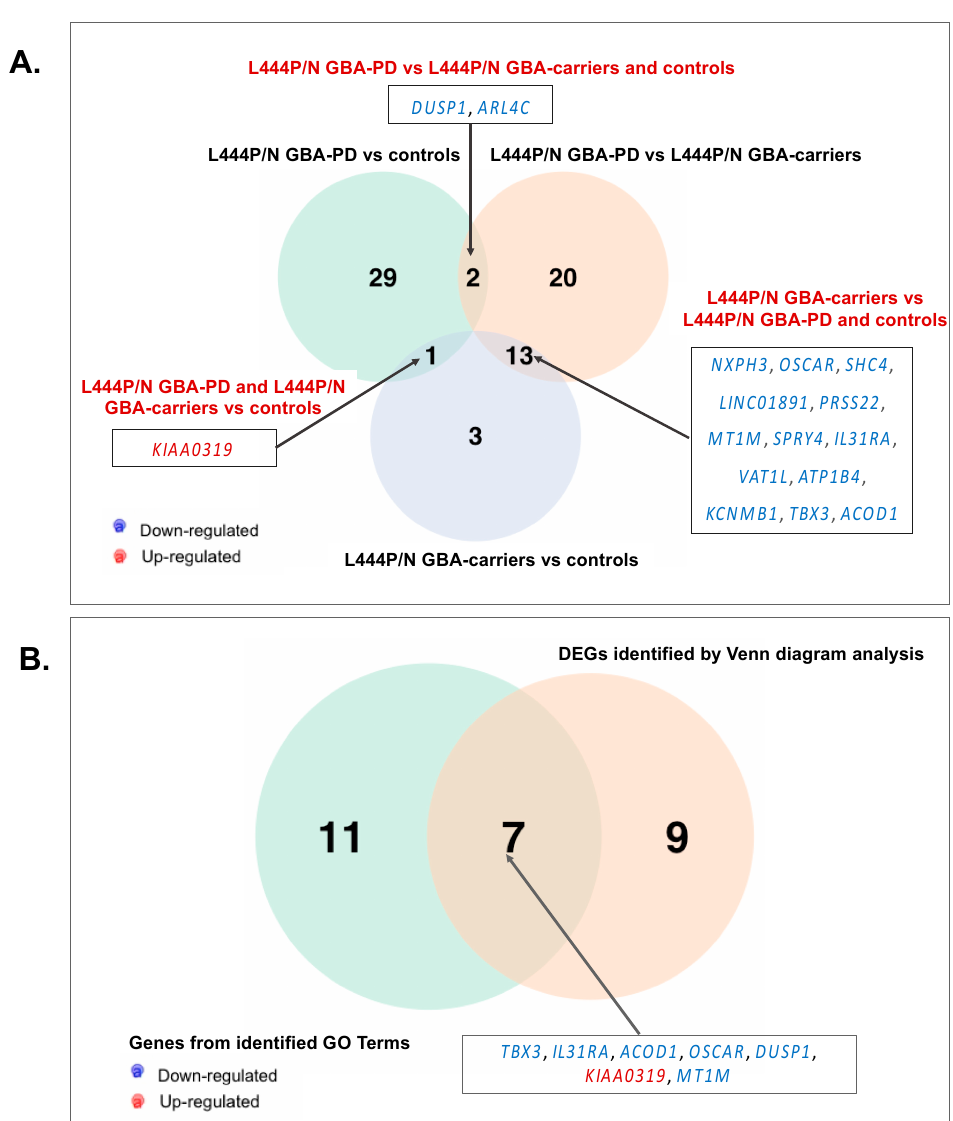
Figure 3. Venn diagram of ( A ). DEGs in monocyte-derived macrophages of L444P/N GBA-PD patients to controls compared to L444P/N GBA-PD patients to L444P/N GBA carriers, and compared to L444P/N GBA carriers and controls. B. DEGs determined be the Venn diagram in ( B ) and DEGs determined by GO analysis for L444P/N GBA-PD patients, L444P/N GBA carriers, controls. All data are presented as the number of genes with a p -value < 0.05 and |FC| more than 1.5. Three Venn diagrams were developed using the library VennDiagram (v.1.6.20) in R (v.4.0.3). (GBA-PD—Parkinson’s disease associated with mutations in the GBA gene; GBA carriers—asymptomatic GBA mutation carriers; DEGs—differentially expressed genes; GO—gene ontology).